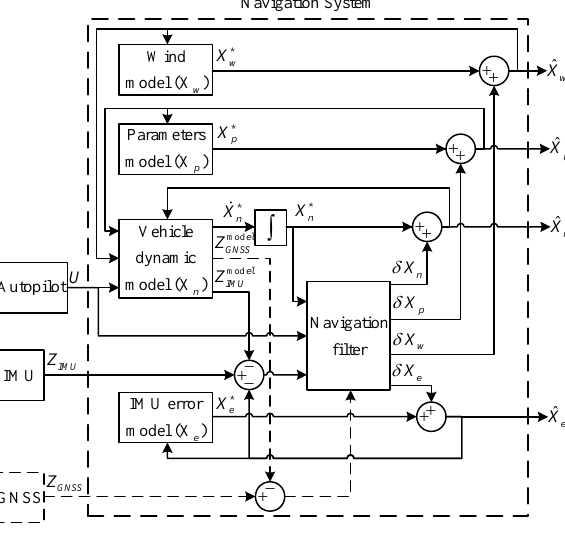
Figure 2: Navigation system